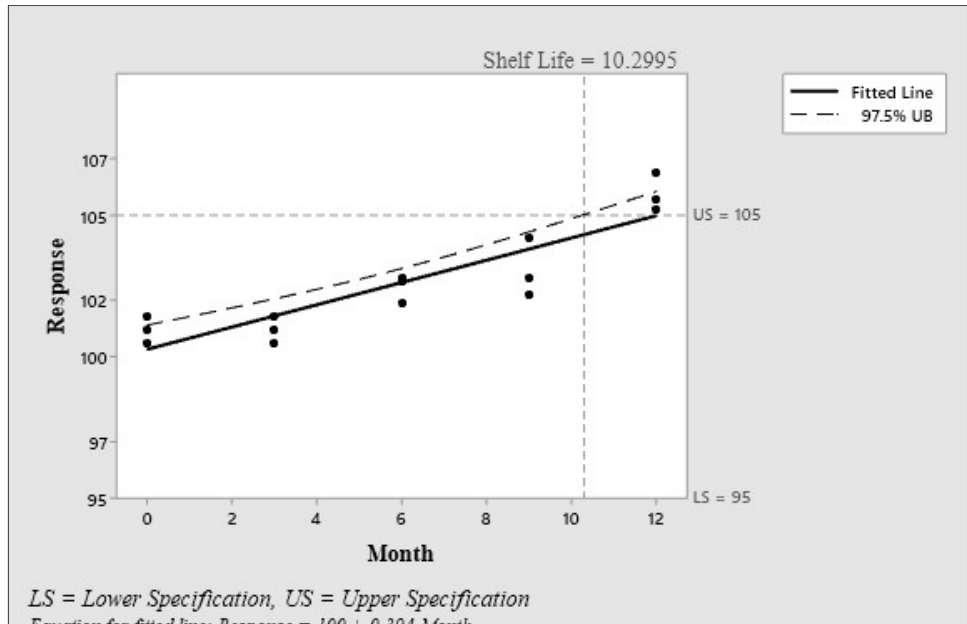
Figure 3. Shelf-life plot.